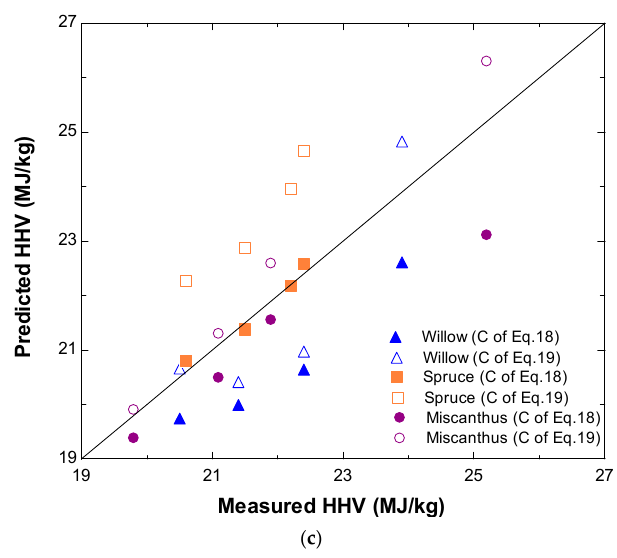
Figure 4. Comparison of the predicted and measured values of ( a ) Carbon content, ( b ) Hydrogen content and ( c ) HHV.